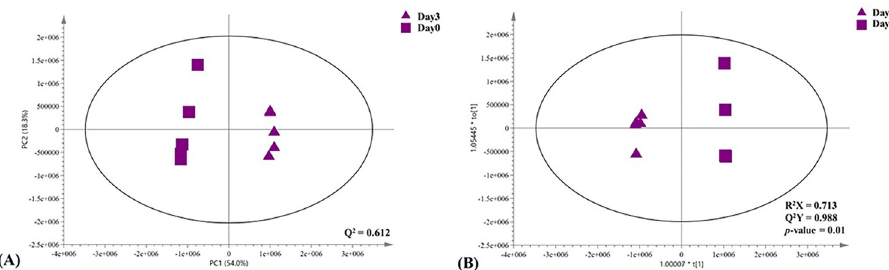
Fig 4. Overview of metabolic similarities and differences metabolic profiles from SPMAP09 strain after crystallization in AU observed at day 0 (squares) and day 3 (triangles); (A) PCA score plots and (B) O-PLS-DA score